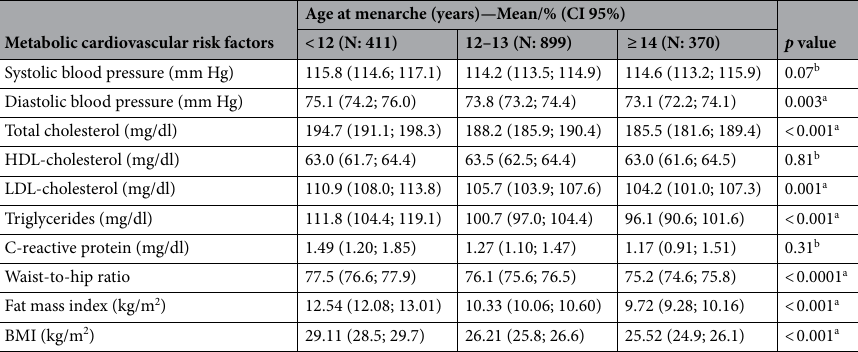
Table 2. Mean and percentage of the metabolic cardiovascular risk factors at 30 years by age at menarche categories. a Linear trend test. b Heterogeneity test. p value: difference in values between groups of age at menarche, p < 0.05 was statistically significant.